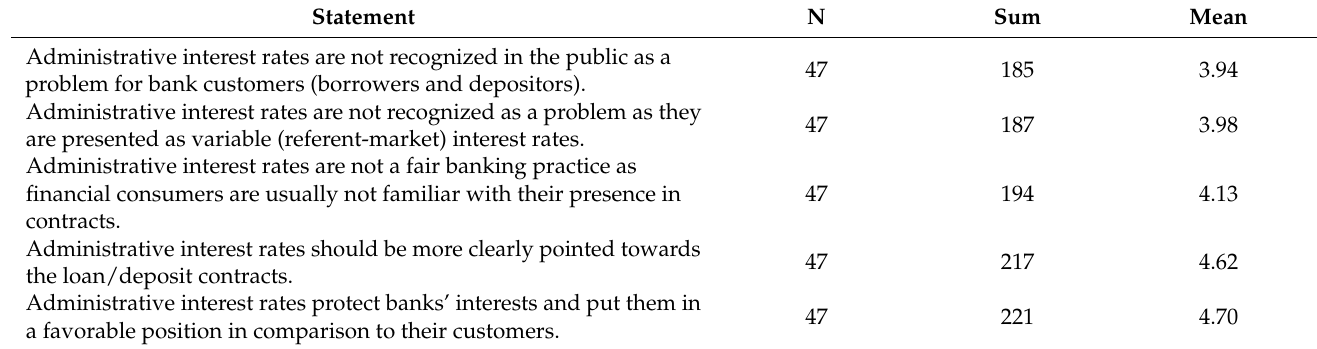
Table 10. Descriptive statistics of points assigned to statements about administrative interest